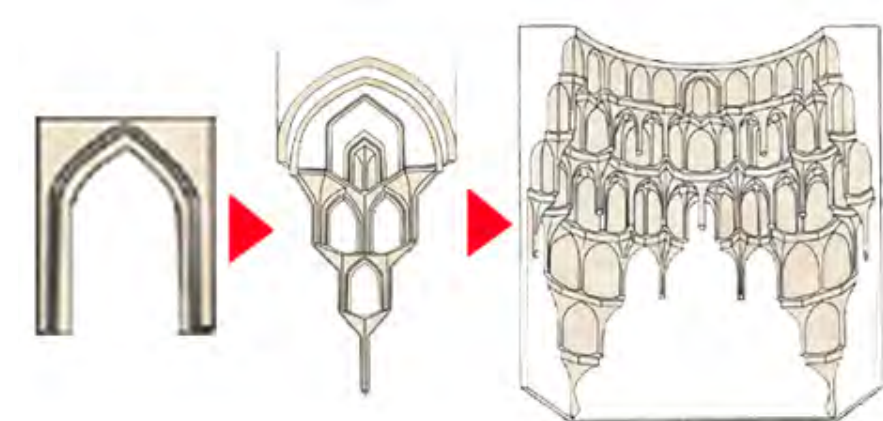
Figure 4. Mainsteps of muqarnas creation